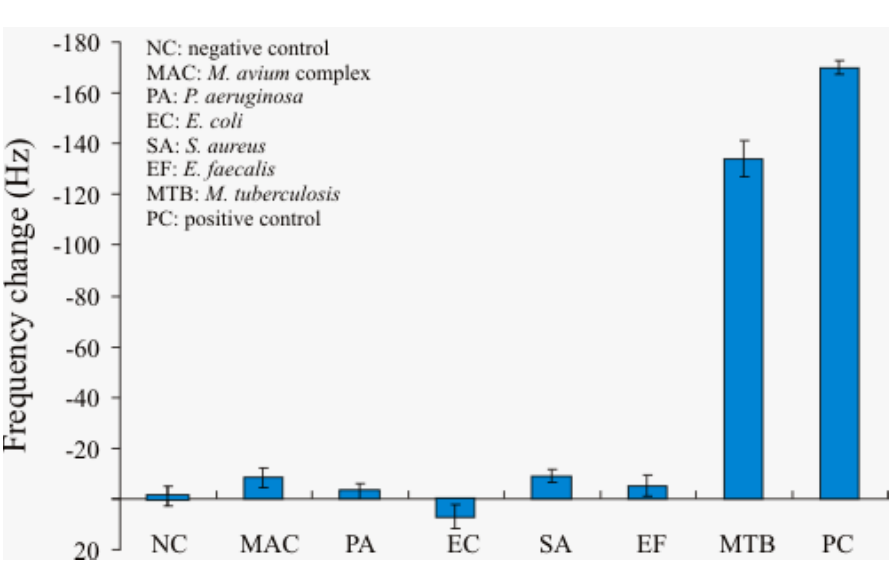
Figure 4. Resonance frequency change of quartz crystal for evaluation of piezoelectric DNA-based biosensor system. Six digested genomic DNAs were denaturated by thermal treatment plus treatment with blocking oligonucleotides. The hybridization buffer was used as negative control (NC). The synthetic DNA target at 1.5 µM of concentration was used as positive control (PC). Each data point represents the mean ± SD (n = 3).